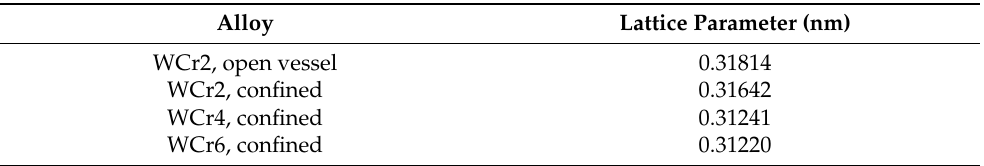
Figure 3. ( a ) X-ray diffraction pattern of the powders after synthesis, lixiviation, rinsing and drying. Miller indices represented correspond to the expected tungsten BCC crystal structure. The other peaks observed on the XRD patterns are attributed to tungsten oxides WO 3 and WO 2 . ( b ) Magnification of the (110) peak. Table 2. Rietveld refinement of powders XRD patterns. Results shown correspond to the main BCC phase